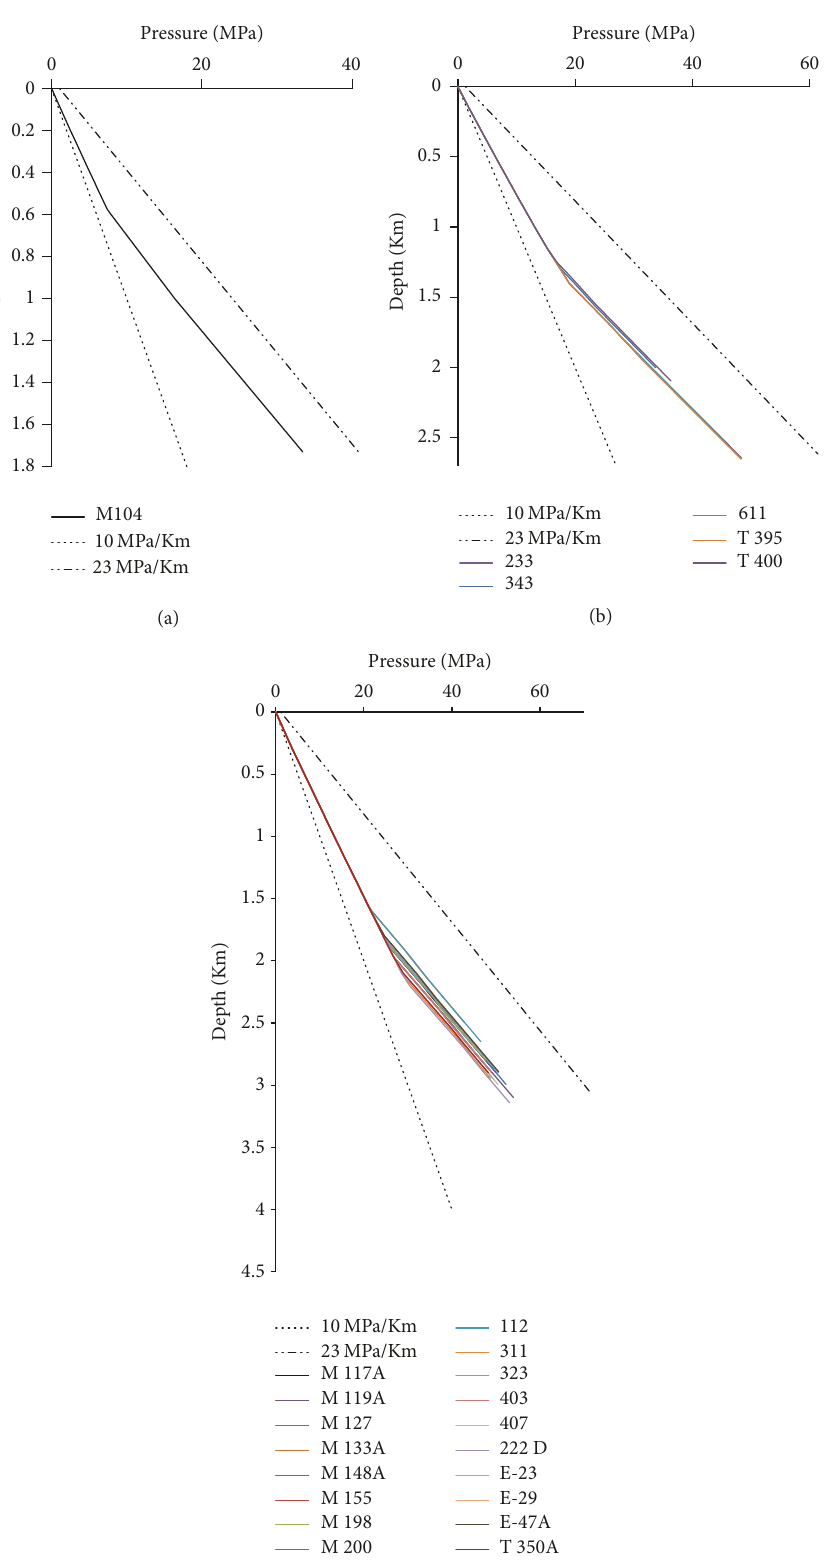
Figure 8: Plots represent pressure estimated conditions at depth: pressure conditions were calculated with the following values: porewater density 𝜌 𝑤 = 1040 kg/m 3 , shale and mudstone density 𝜌 sh = 2700 kg/m3, sandstone density 𝜌 sd = 2720 kg/m 3 , slate density 𝜌 sl = 2750 kg/m 3 , and sedimentary material density 𝜌 sm = 1650 kg/m 3 [10,